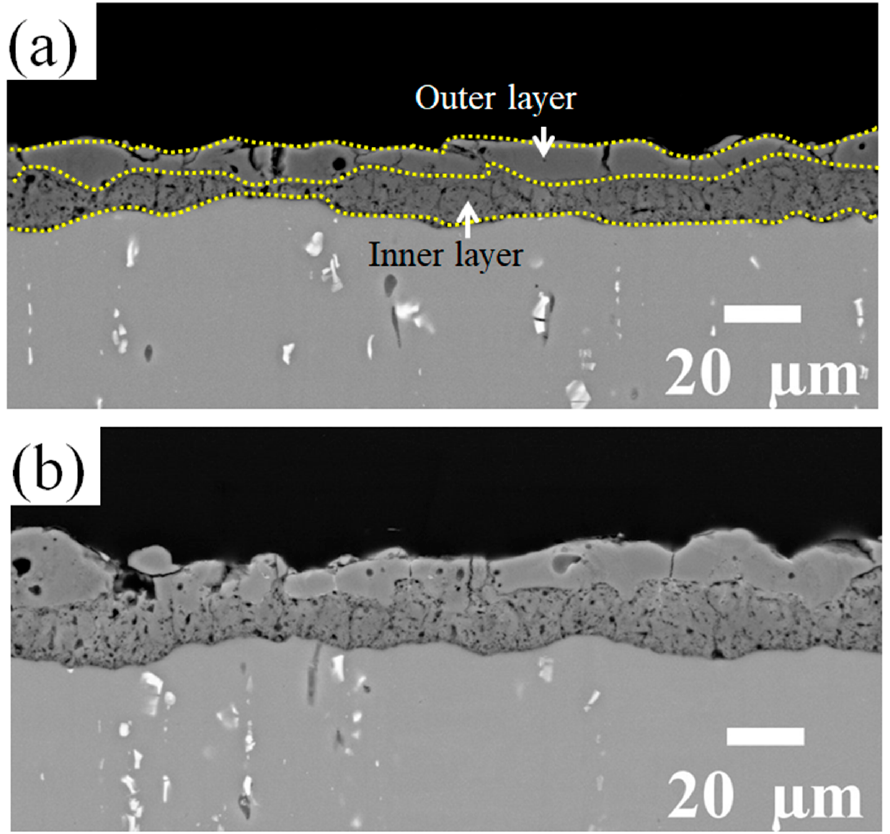
Figure 4. BSD cross-section images of ( a ) the reference coating and ( b ) the coating prepared in the Zr electrolyte. Both PEO coatings exhibit a two-layered structure with a more compact outer layer. Both coatings have a two-layered structure, which includes a more compact outer layer with vertical cracks, and micro-pores and a finely porous inner layer. However, with the addition of Zr-based salt, the number of vertical cracks in the outer layer is decreased, and they are shallower. The thickness of the layers is presented in Figure 5. The addition of Zr-based salt into the PEO bath increased the thickness of the coating’s outer layer from 10 µ m to 12 µ m and that of the inner layer from 8 µ m to 11 µ m when using identical parameters in the PEO